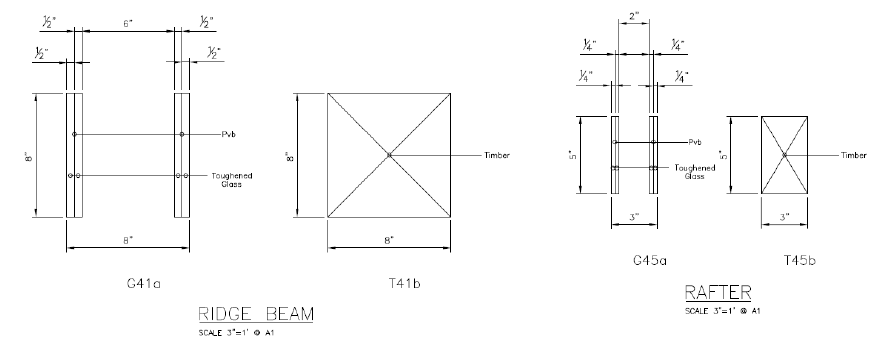
Figure 3: Shop Drawings Showing New Glass and Original Timber Sections Side by